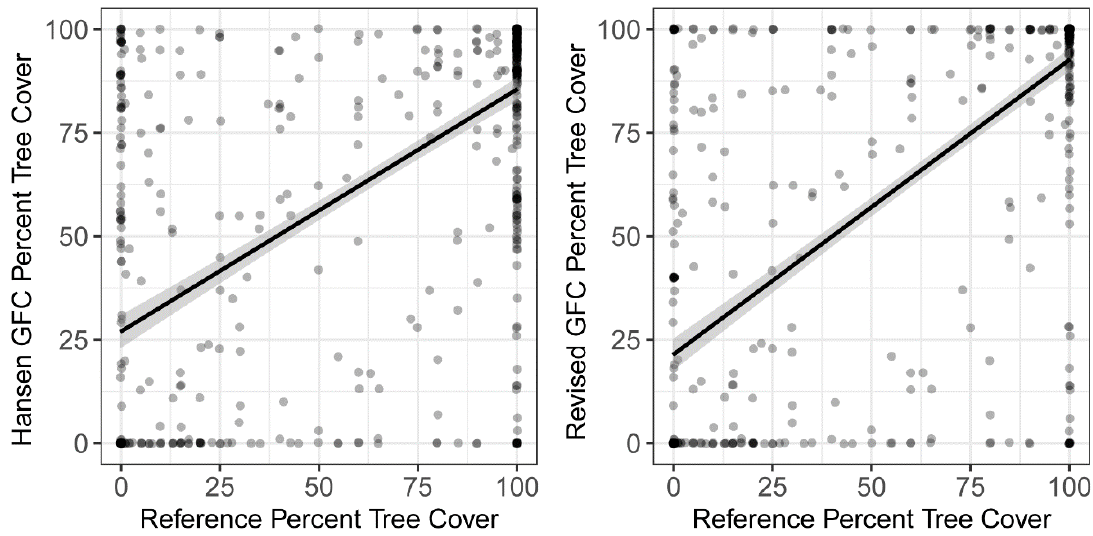
Figure 7. Percent tree cover accuracy for the original and revised 2015 GFC products, which were evaluated by comparing reference tree cover to tree cover predicted by the GFC. Because of overplotting, the point data are represented by semi-transparent gray points. The black line indicates a significant mean fit for an untransformed linear regression, and the gray region indicates the confidence intervals for the prediction.